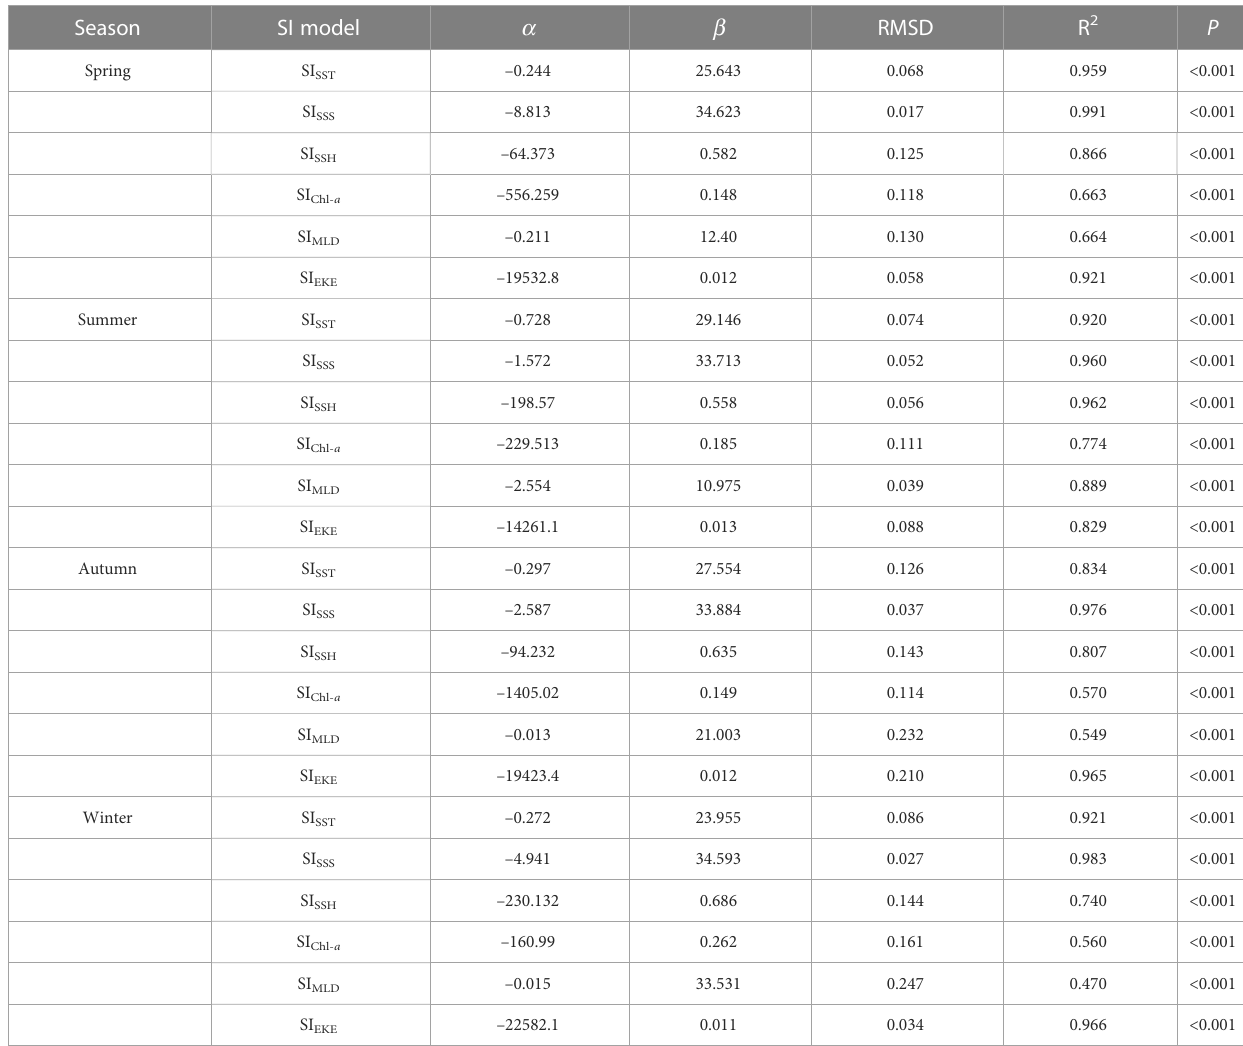
TABLE 2 Seasonal fi tted suitability index (SI) model for all the environmental variable; a and b are the estimated parameters of the SI model, and RMSD indicates the root mean square difference.